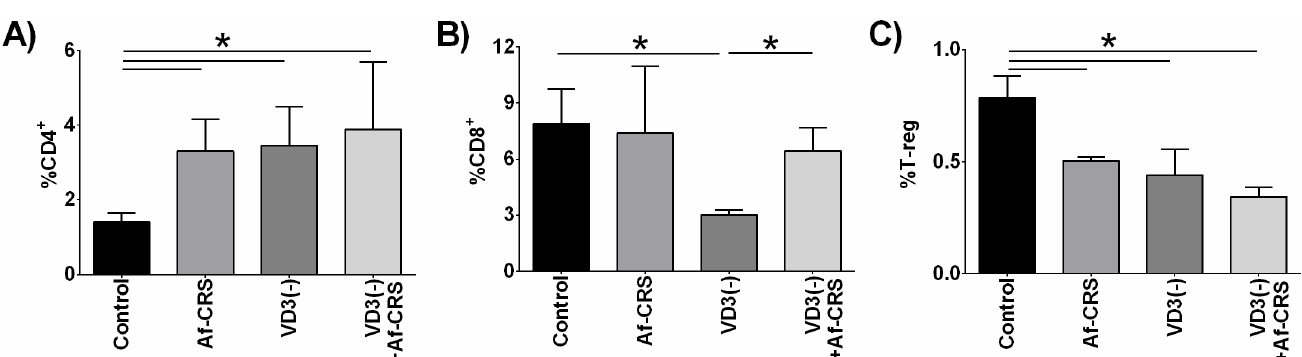
Fig 8. VD3 deficiency alone causes changes in sinonasal CD4 and T-regs similar to Af-CRS. Sinonasal( A ) CD4, ( B ) CD8 and ( C ) T-regulatory cells (CD4 + CD25 + FoxP3 + ) were identifiedby immunostaining and flow cytometric analysis. * p < 0.05betweenindicatedgroups. n = 4-5/group.